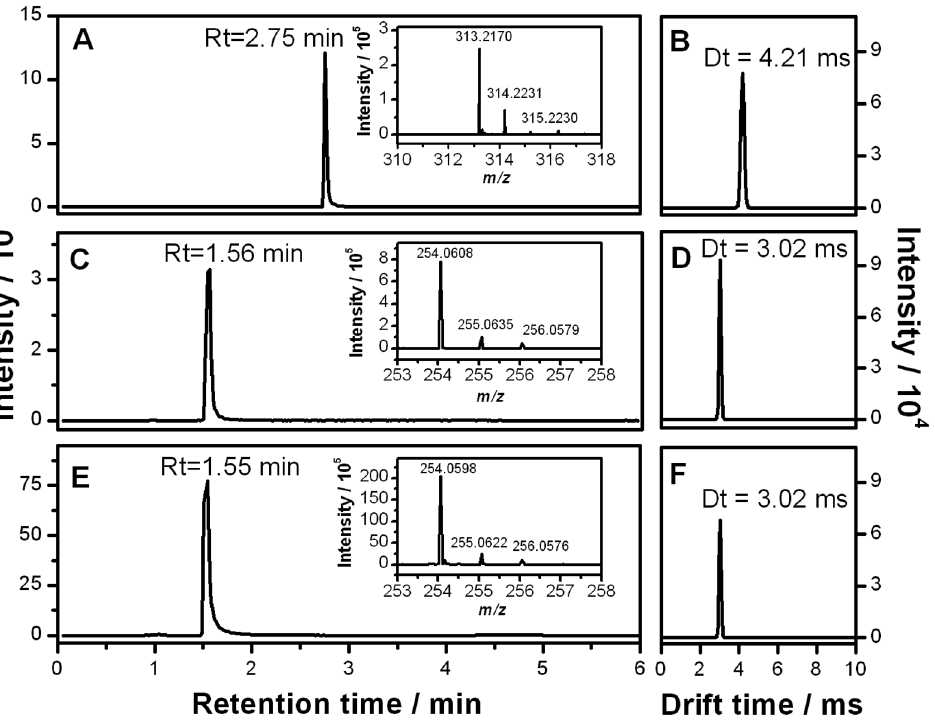
Figure 3. UHPLC-IMS-TOF-MS analysis. Extracted ion chromatogram (A) and extracted ion mobility chronogram (B) for a levonorgestrel standard with m/z 313.2168 6 0.005. Extracted ion chromatogram (C) and extracted ion mobility chronogram (D) for sulfamethoxazole standard with m/z 254.0599 6 0.005. Extracted ion chromatogram (E) and extracted ion mobility chronogram (F) for sulfamethoxazole in the poor quality contraceptive tablet with m/z 254.0599 6 0.005. Mass spectra for the target compounds are displayed as insets.